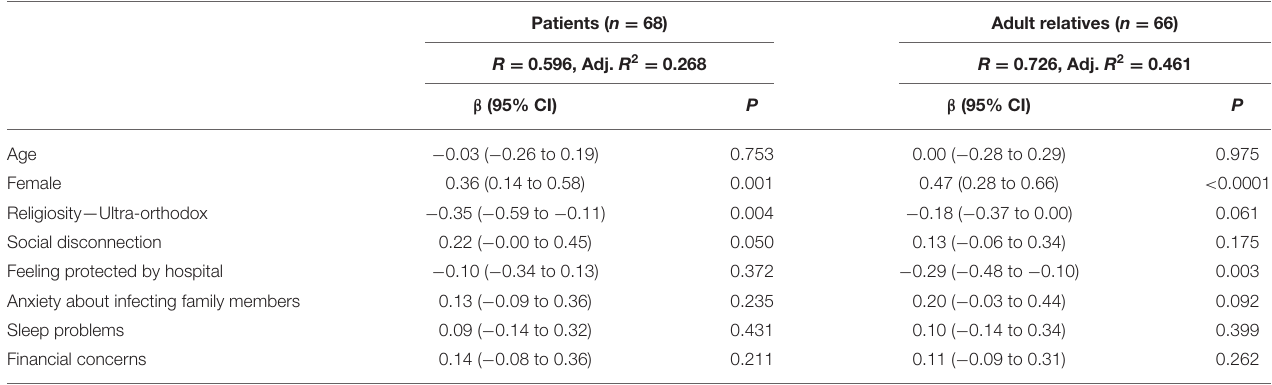
TABLE 2 | Factors associated with anxiety among adult patients and their adult